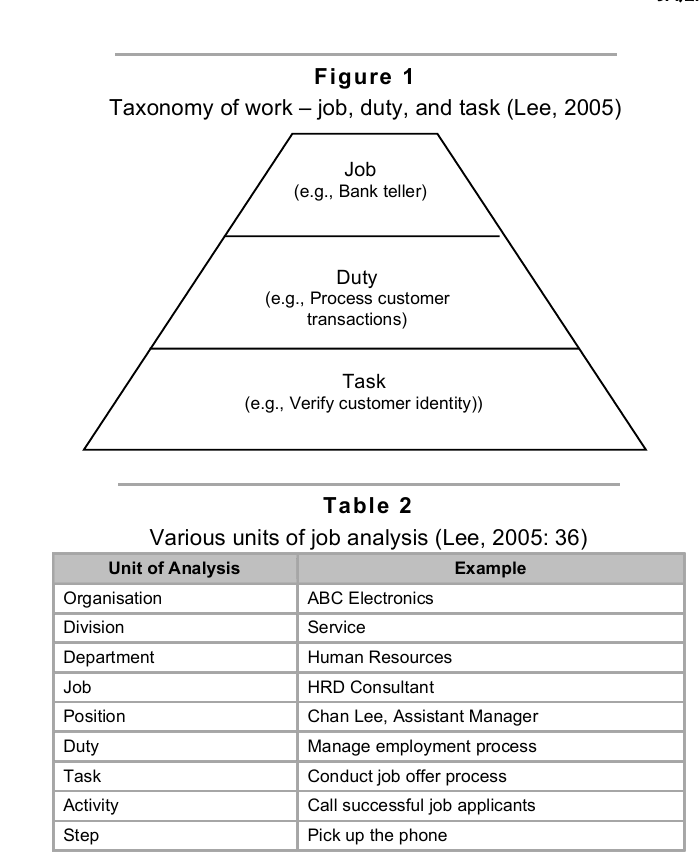
Various units of job analysis (Lee, 2005: 36) Unit of Analysis